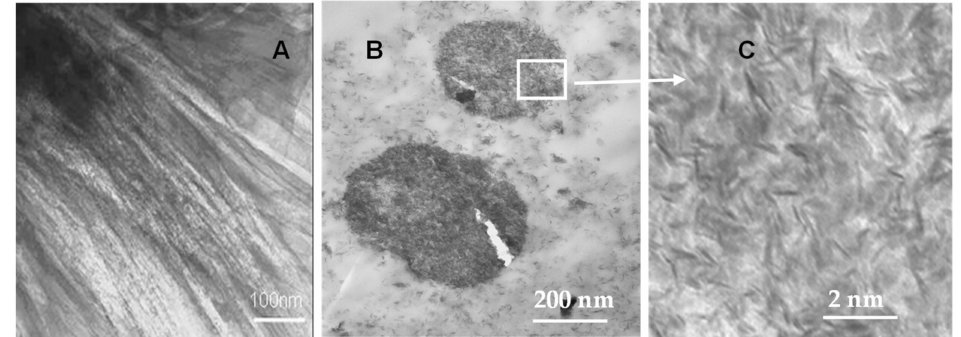
Figure 2. TEM micrograph of pure C beads ( A ), C-LDH(1) beads ( B ), and of the latter under higher magnification ( × 100) of the selected area ( C